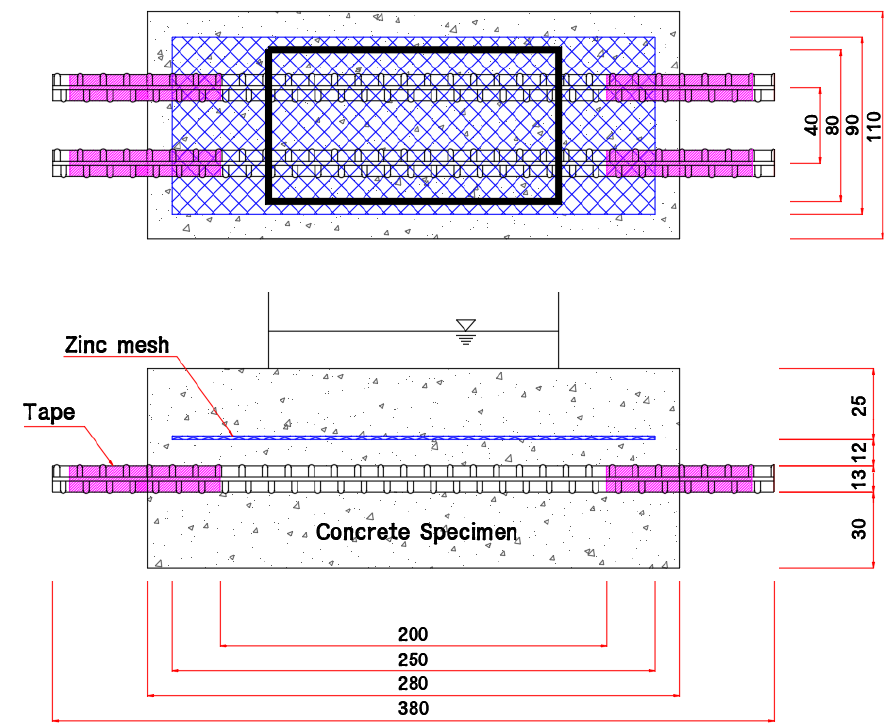
Figure 7. Drawing of conductive mortar specimen (units in mm).